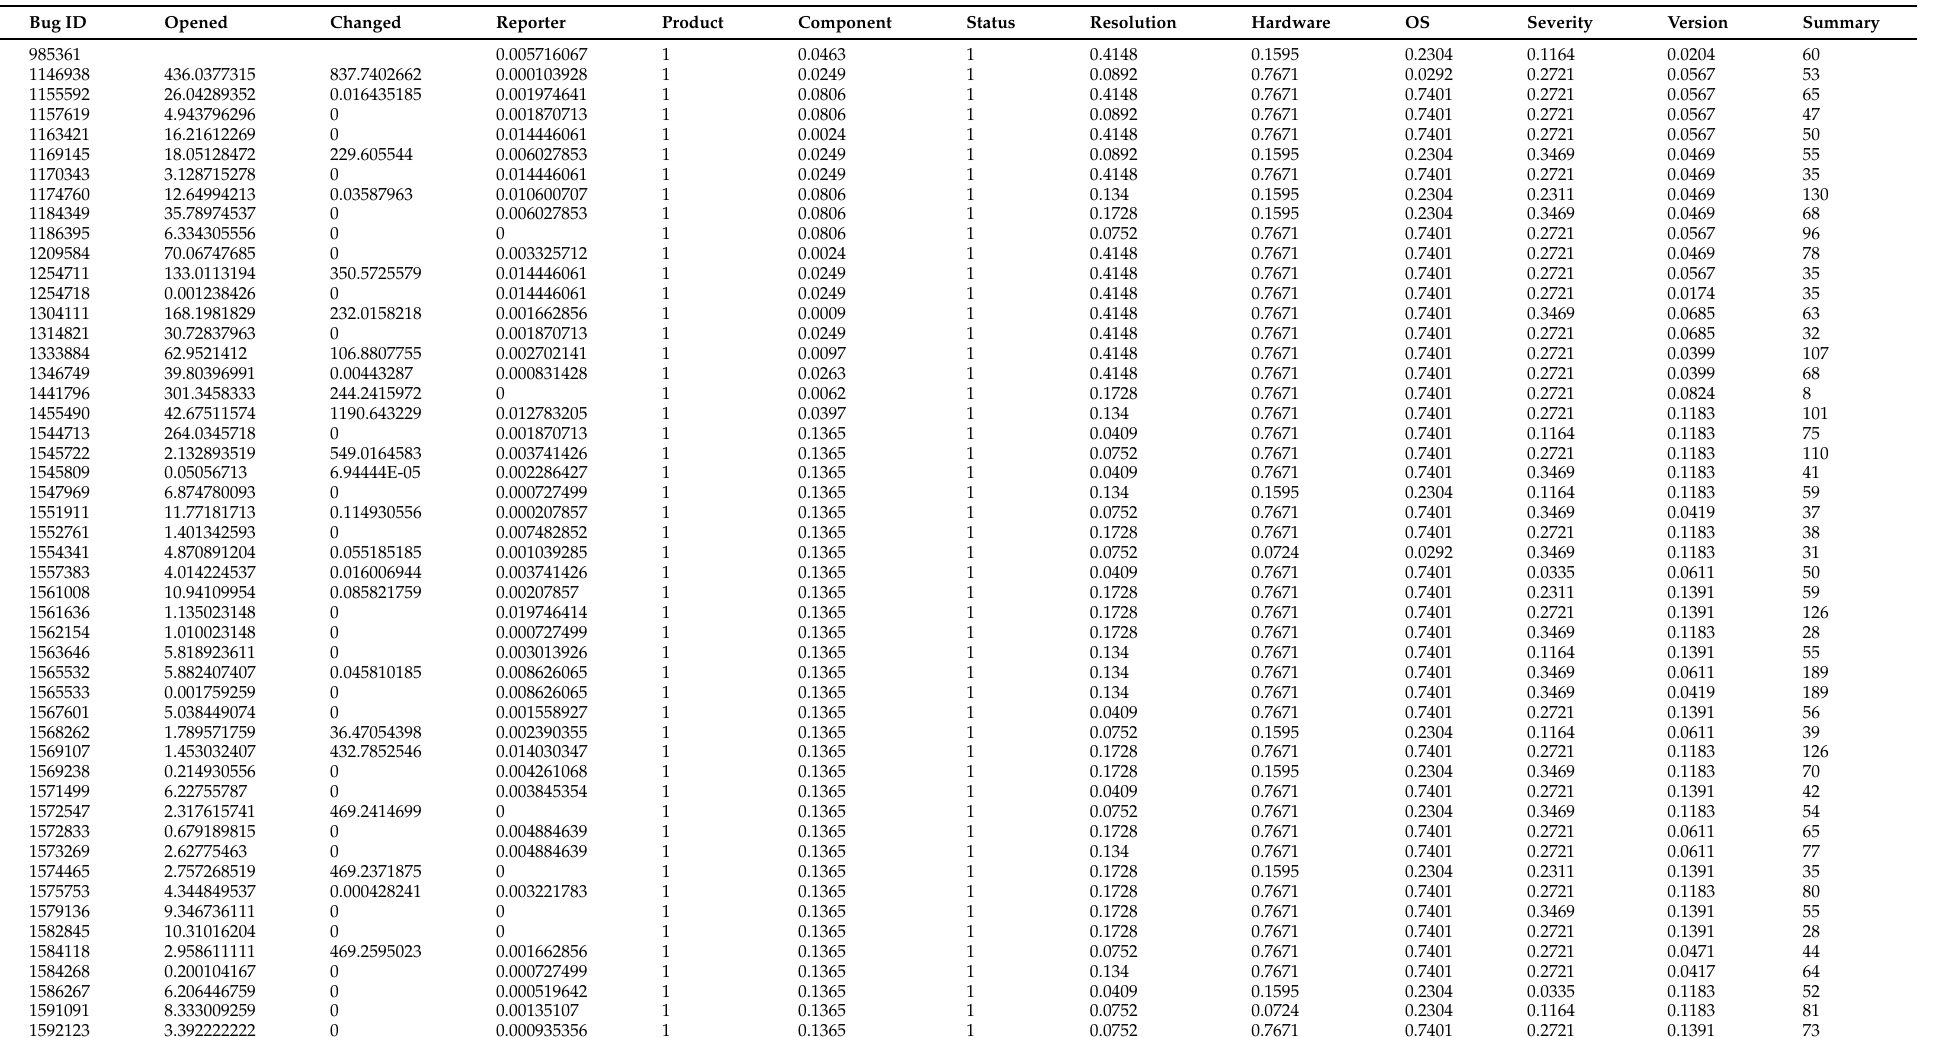
Table 2. A part of the numeric values converted from the raw